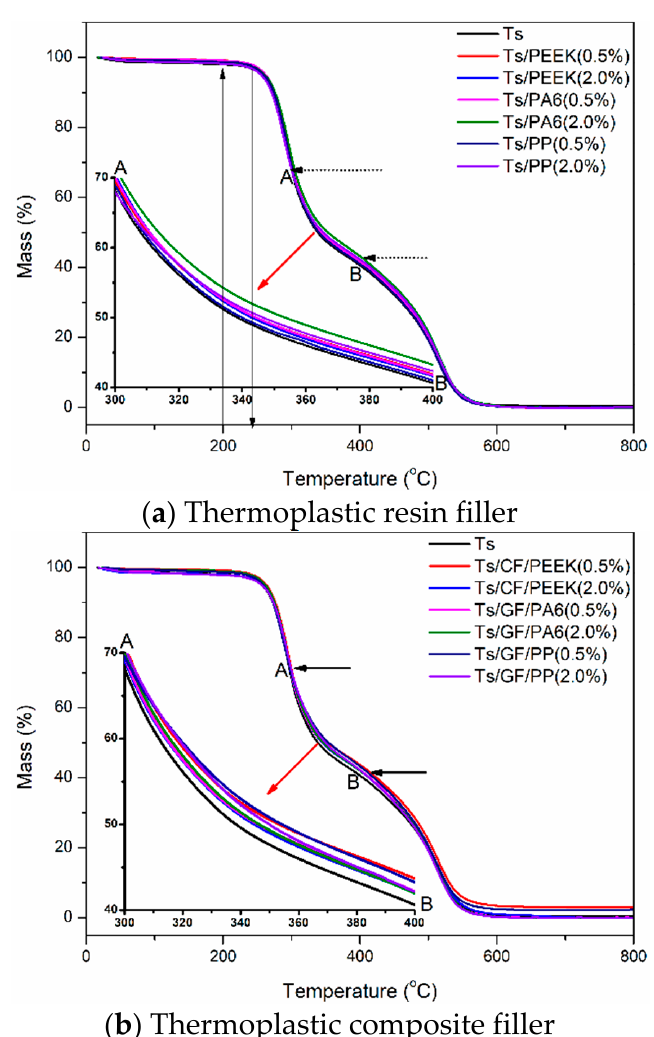
Figure 13. Effects of thermoplastic resin and composite fillers on weight loss of Ts resin at elevated temperatures of ( a ) thermoplastic resin filler and ( b ) thermoplastic composite filler. It was noted that AB denoted the typical decomposition zone. Table 2. Effects of thermoplastic resin and composite fillers on the thermal properties of Ts resin.